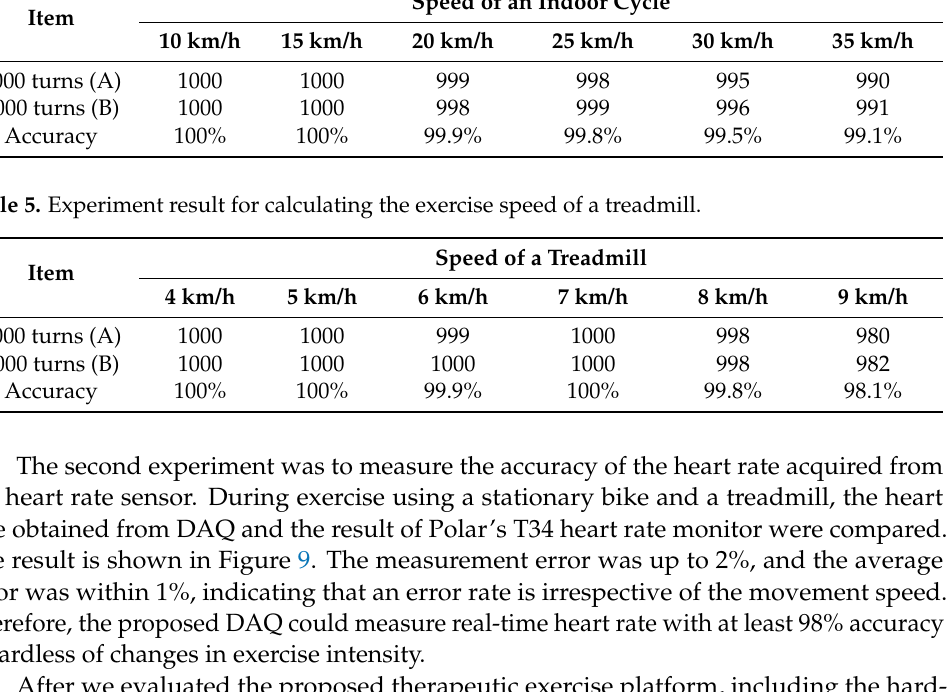
Table 4. Experiment result for calculating the exercise speed of an indoor cycle. Item